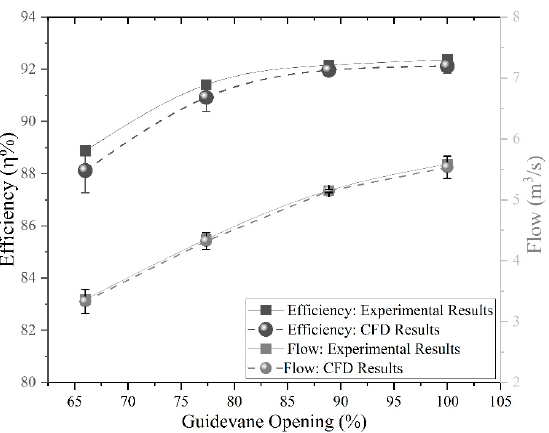
Figure 5. Prototype discharge and efficiency comparison with the simulated results for various op-